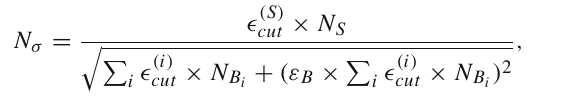
Z Z (γ ∗ ) classification comes at the cost of a slight increase in mistagging of t ¯ t events as W W